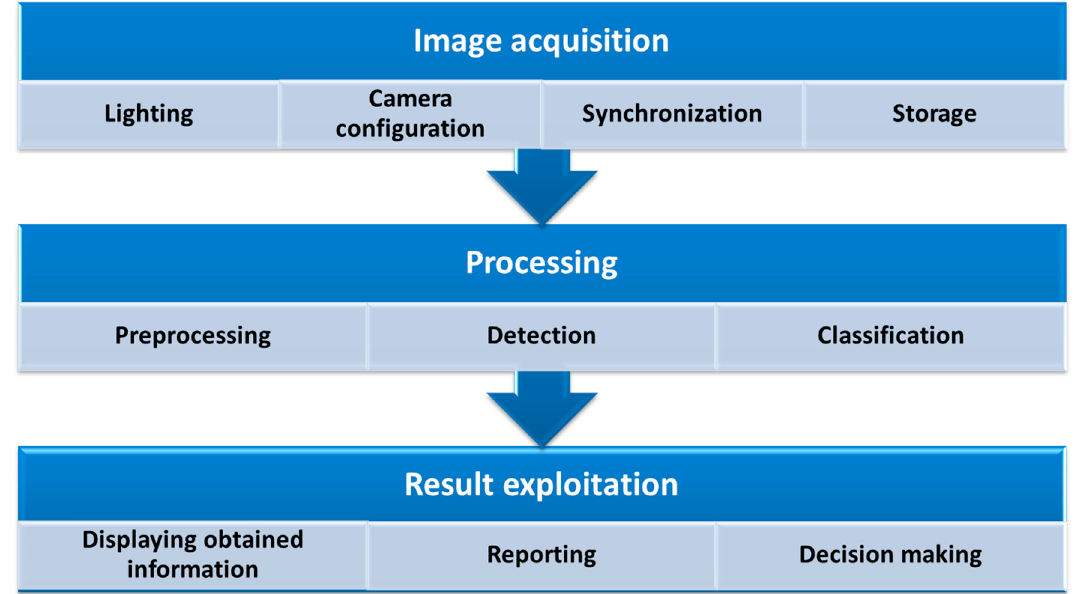
Figure 2. Stages of the automatic visual inspection process.